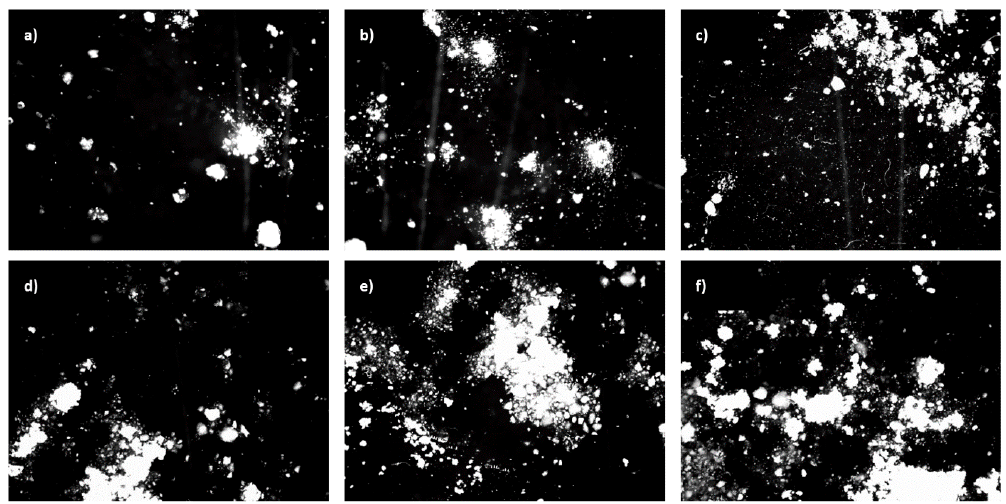
Figure 3. Polyol premixes with ( a ) 0.5 wt%, ( b ) 1.5 wt% and ( c ) 5 wt% of AEAPIB-POSS and ( d ) 0.5 wt%, ( e ) 1.5 wt% and ( f ) 5 wt% of APIB-POSS. ( e ) 1.5 wt% and ( f ) 5 wt% of